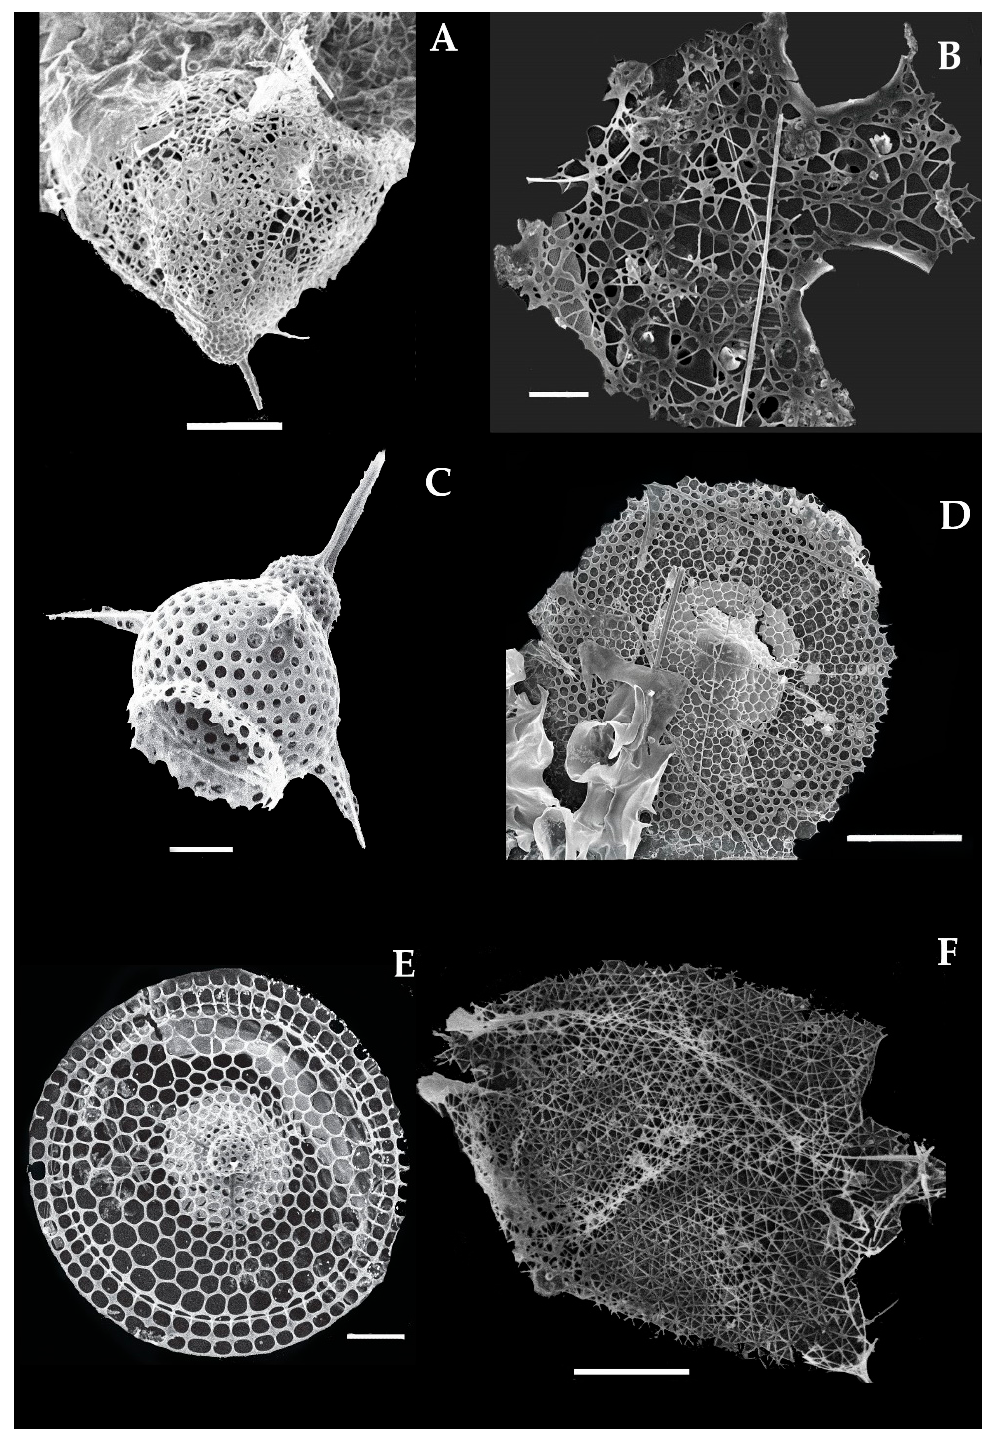
Figure 10. Light and scanning electron micrographs of Nassellarian species ( A – F ) These images were modified from Munir et al. [27]. ( A , B ) Sethoconus venosus, ( C ) Theocorys veneris, ( D ) Theophormis callipilium , ( E ) Theopilium tricostatum ; ( F ) Cephalospyris cancellate. Scale bar: 10 µ m, 20 µ m, 50 µ m. 3.7.1. Siphonosphaera magnisphaera Takahashi 1991 (Figure